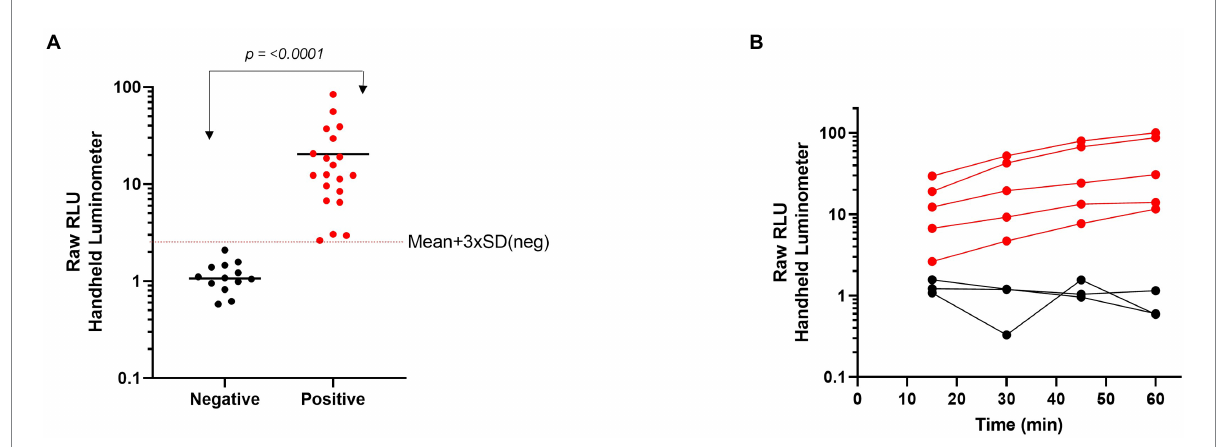
FIGURE 6 Characterization of a single-reagent SARS-CoV-2 antigen assay for point-of –care testing with nasal clinical samples. (A) Clinical samples that had previously been identified by PCR as negative ( n = 13) or positive ( n = 20) were added directly to the lyophilized N-antigen assay then read with a handheld luminometer after 15 min. (B) A subset of clinical samples were added to the lyophilized N-antigen assay and measured at 15 min intervals over a 1 h time period. Statistical analyses performed by using unpaired, non-parametric Mann–Whitney t